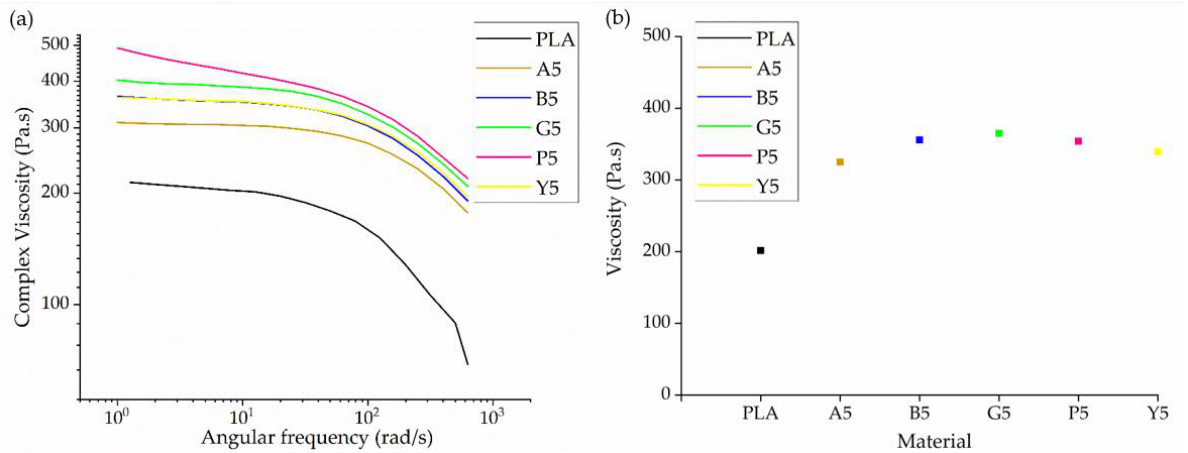
Figure 5. Rheological analysis of PLA and its master batches containing 5% ( w / w ) of each colorant. ( a ) Rheogram of PLA and the five master batches. ( b ) Complex viscosity of PLA and the five master batches at an angular frequency of 10/s.